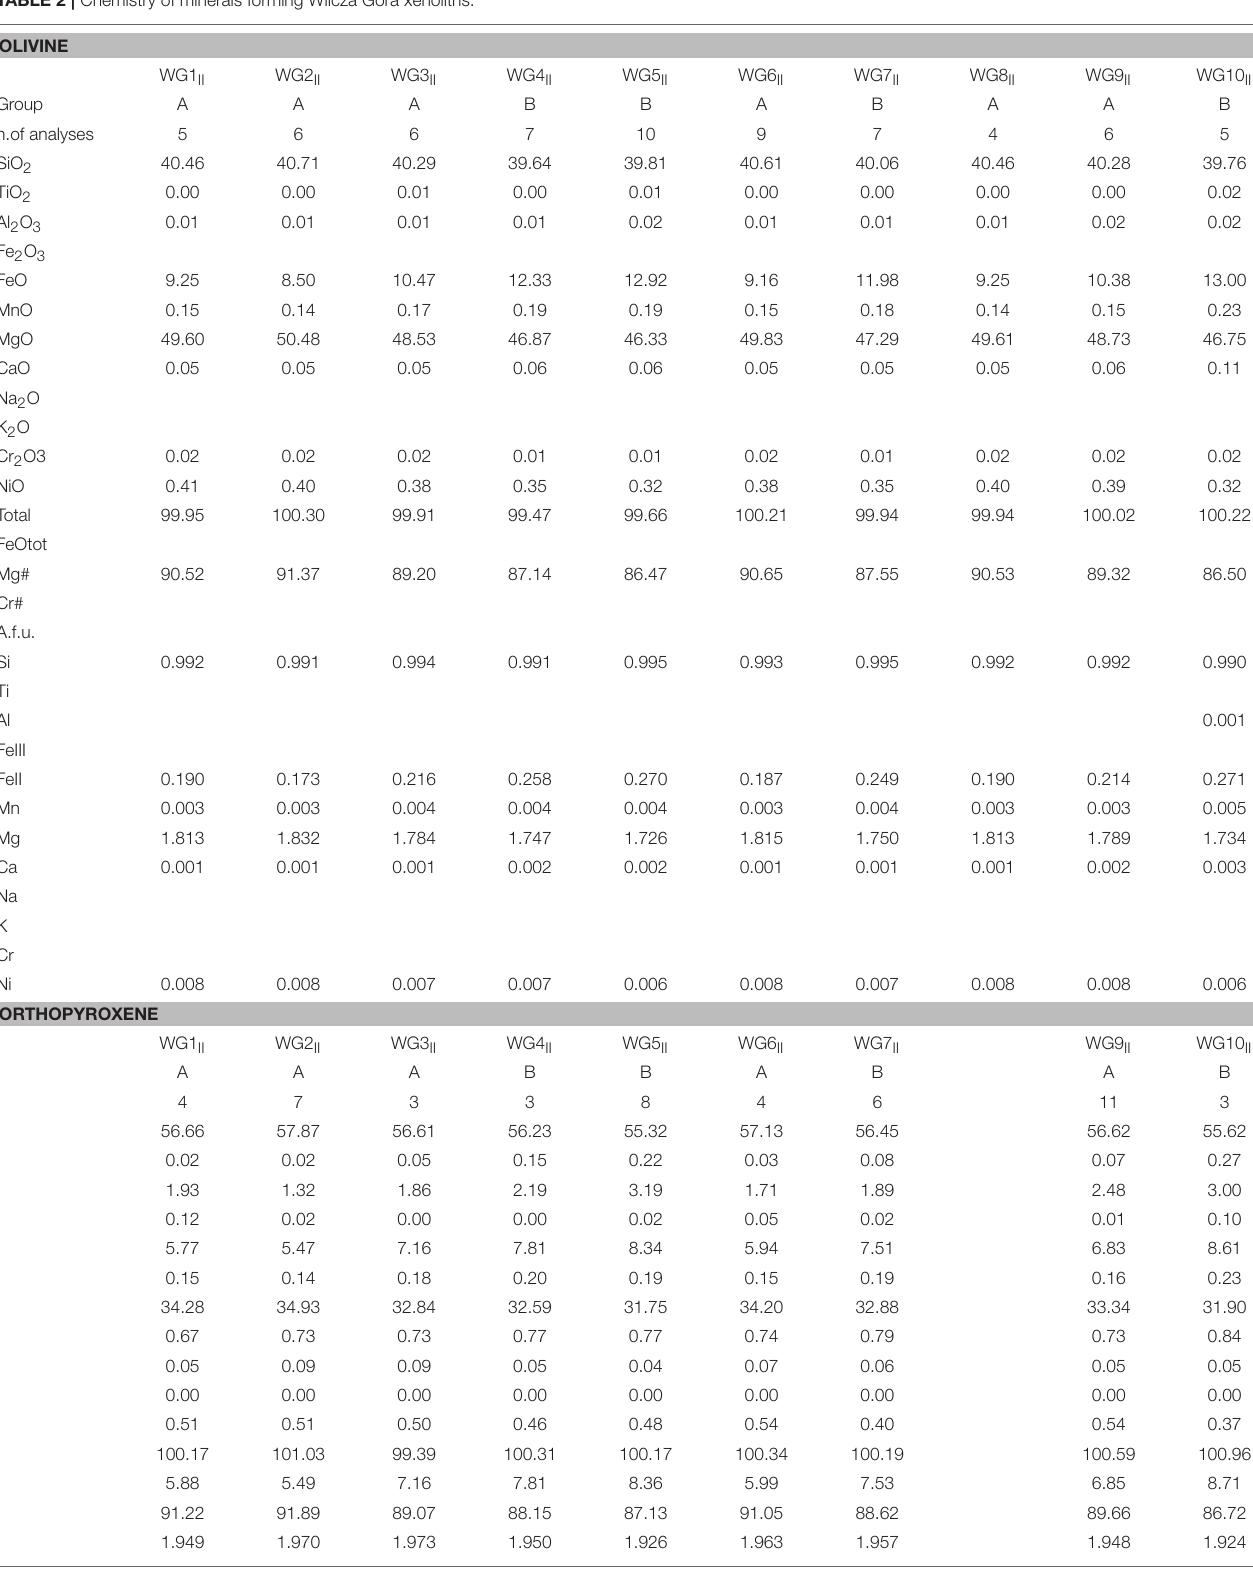
TABLE 2 | Chemistry of minerals forming Wilcza Góra